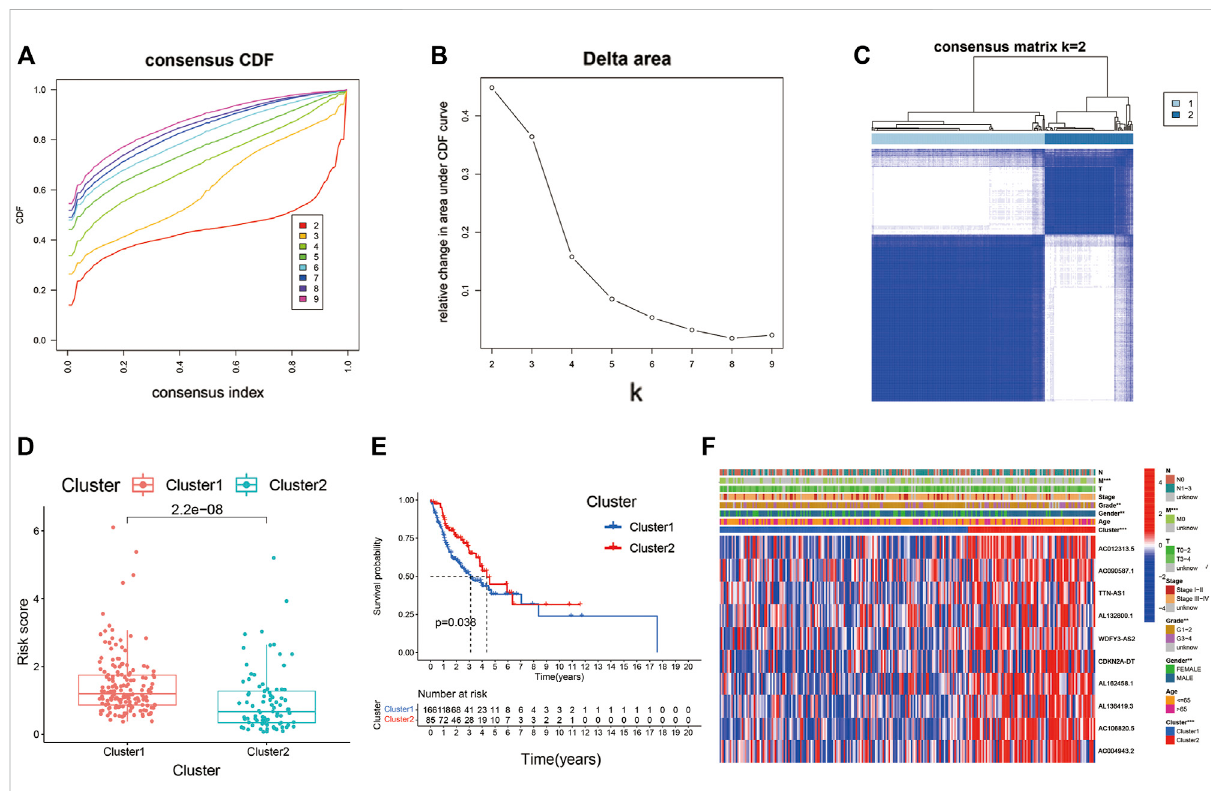
FIGURE 9 Consensusclusteringidenti fi edthemolecularsubtypesofHNSC. (A) Consensusclusteringcumulativedistributionfunction(CDF)fork=2to9. (B) Relative change in area under the cumulative CDF curve for k = 2 to 9. (C) Consensus matrix for k = 2. (D) The difference of risk scores between Cluster1 and Cluster2. (E) The different OS between Cluster1 and Cluster2. (F) Relationships between Cupr-RLs expression and